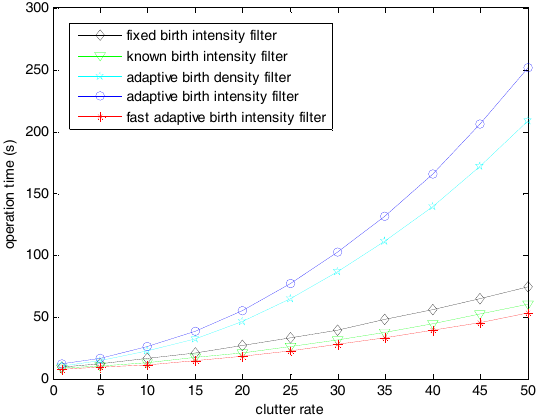
Table 4. Operation time of different filters with a clutter rate of 50.